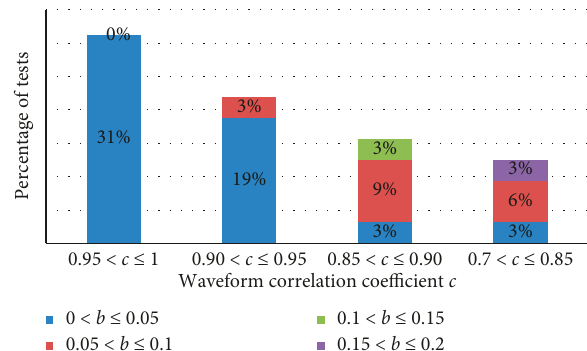
Figure 32: Accuracy distribution diagram based on correlation